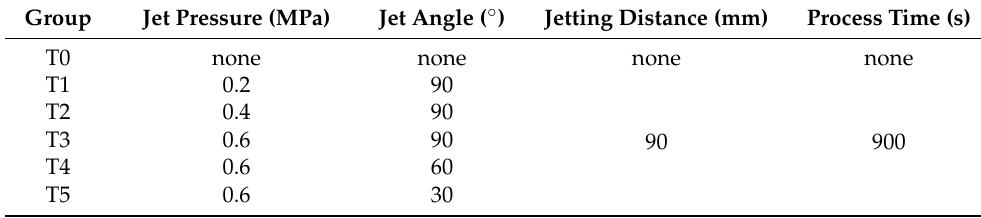
Table 3. Parameters of single-factor